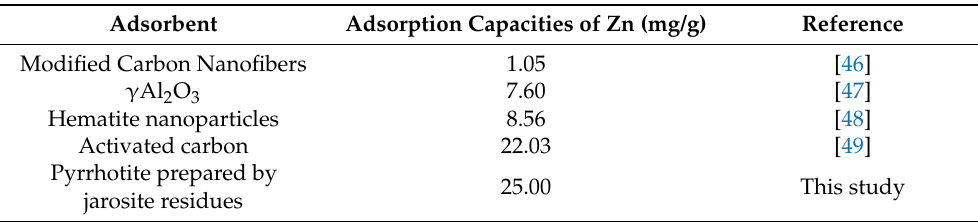
Table 1. Comparison of Zn removal with different adsorbents reported in the literature. Adsorbent